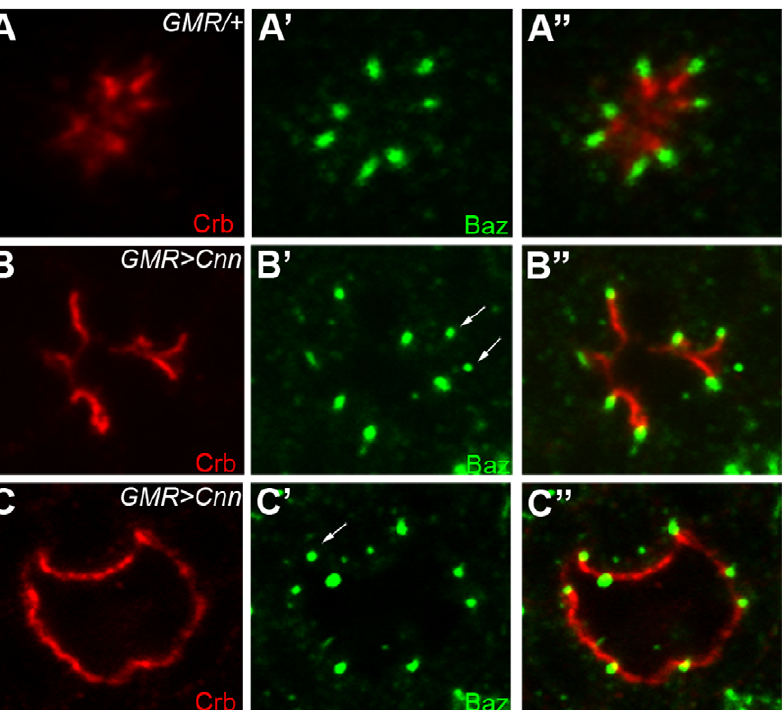
Figure 5. Overexpression of Cnn causes the apical domain expansions. Pupal eyes (50% pupal developmental stage) with Cnn overexpression driven by GMR-GAL4 at 29 u C were examined by Crb (green, apical domain marker), and Baz (green). (A) control, GMR-GAL4/ + . (B, C) GMR-GAL4/UAS-GFP-Cnn . The expanded Crb domain (red) and Baz (green) were caused by the Cnn overexpression (B). The ectopic localizations of Baz are indicated by arrows (B 9 , C 9